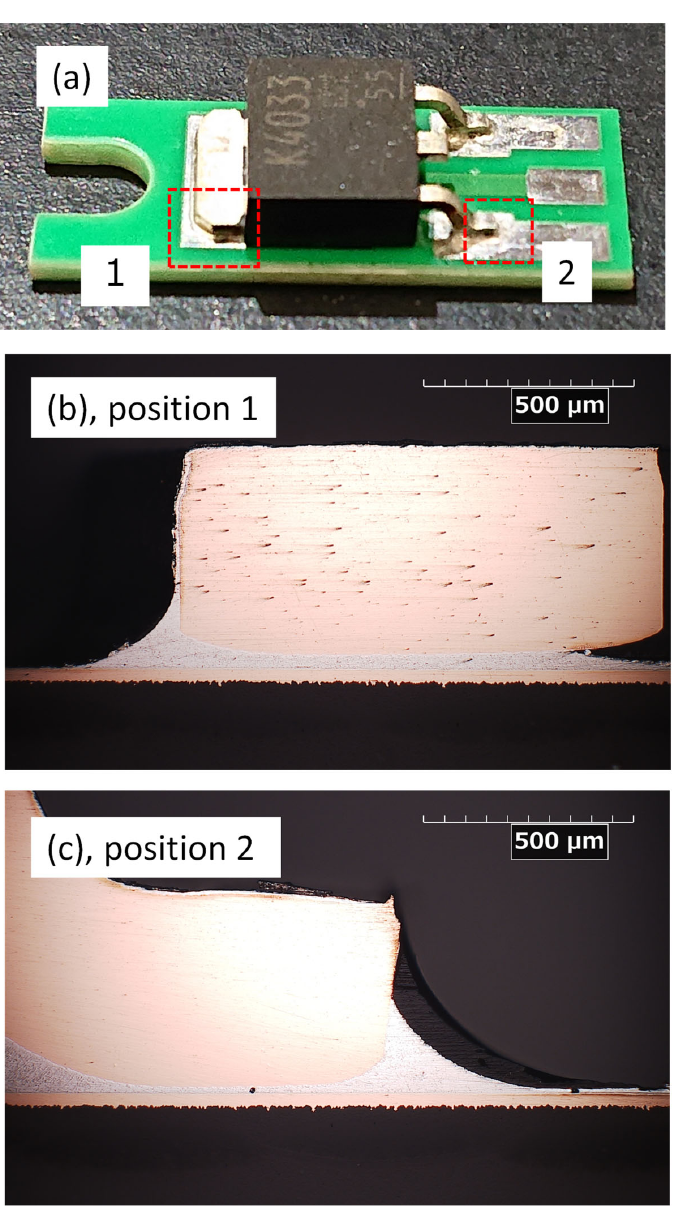
Figure 5. Exterior image of a sample heated by a magnetic field ( a ) and digital microscope images of the junctions ( b , c ).